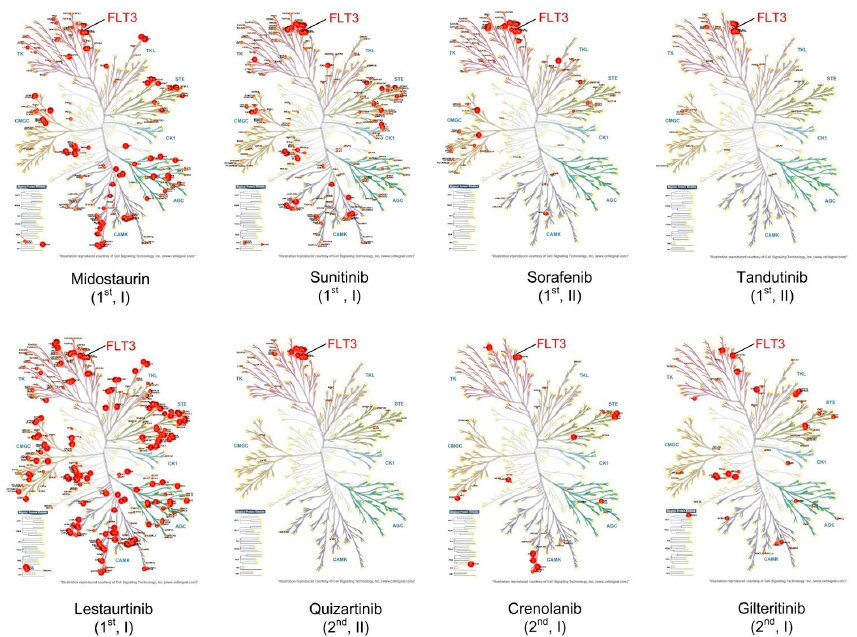
Figure 3. Kinase targets of first- and second-generation FLT3 inhibitors. Kinase trees depicting the dissociation constant ( Kd , (nM)) of the target kinases of each inhibitor. Size of red bubble is proportional to the Kd value, with a larger bubble indicating a lower Kd . First generation inhibitors = 1st, second generation inhibitors = 2nd. Brackets indicate whether the inhibitor is type I or type II. Illustrations reproduced Courtesy of Cell Signaling Technology, created using KinMap [138], with data from references